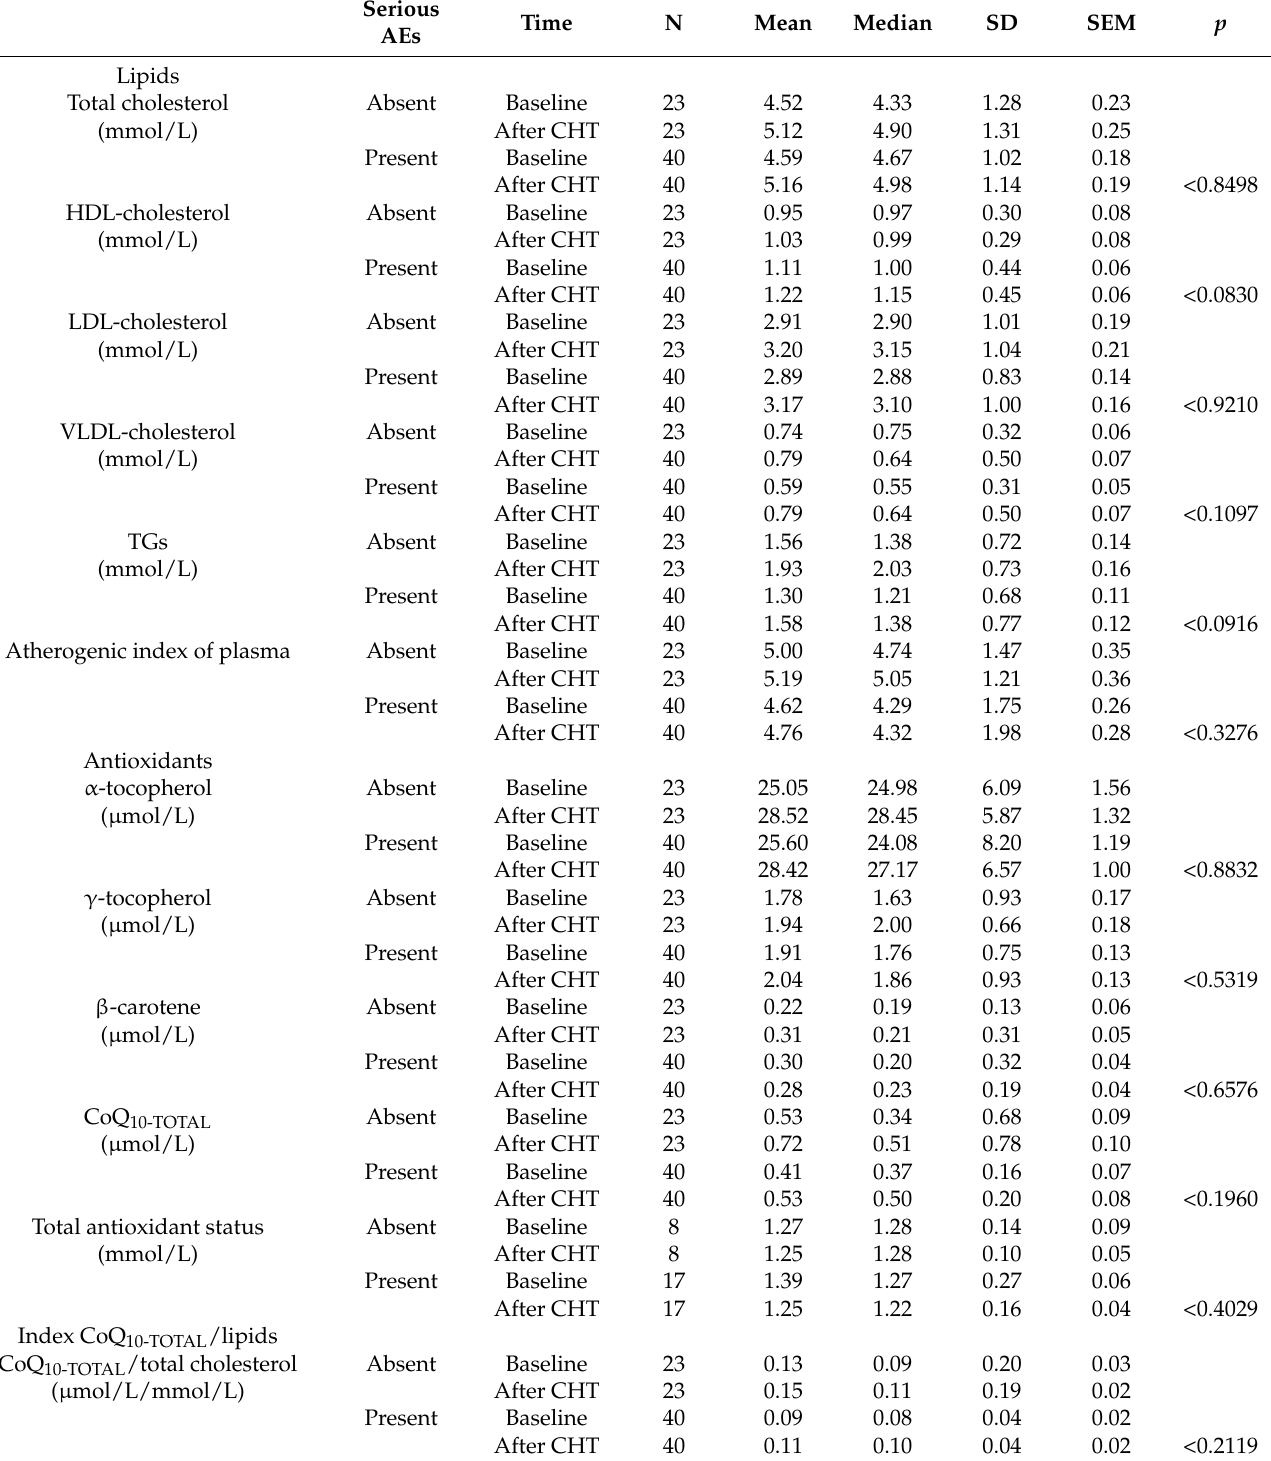
Table 5. Plasma lipids, antioxidants, index CoQ 10-TOTAL /lipids, and oxidative stress baseline vs. after two courses of chemotherapy in metastatic urothelial carcinoma (mUC) patients—a subgroup analysis by serious adverse events (AEs). N: number of patients; SD: standard deviation; SEM: standard error mean; HDL: high-density lipoprotein; LDL: low-density lipoprotein; VLDL: very low- density lipoprotein; TGs: triacylglycerols; CoQ 10 : coenzyme Q 10 ; TBARS: thiobarbituric acid-reactive substances; CHT: